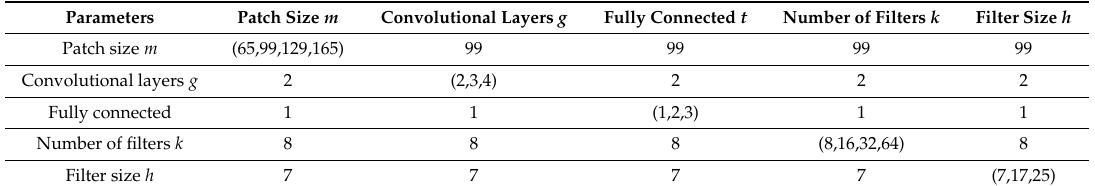
Table 3. A summary of the values used in CNN hyperparameter optimization. The columns represent the experiment carried out. The main diagonal shows the values